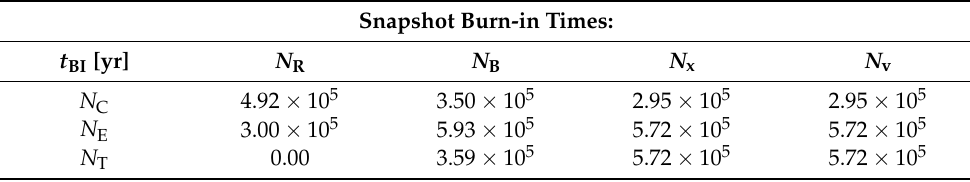
Table 3. Computed burn-in time of a number of populations of the remaining objects, mainly the cluster N C and ejecta N E populations, the population of objects in bounded N B systems, that is, those objects part of multiple, usually binary, system, or even binary within a binary system, and combinations of those. These burn-in times are shown in Figure 7 when computed from position and velocity evolution, along with Figures 8 and 9 when computed from population evolution. Snapshot Burn-in